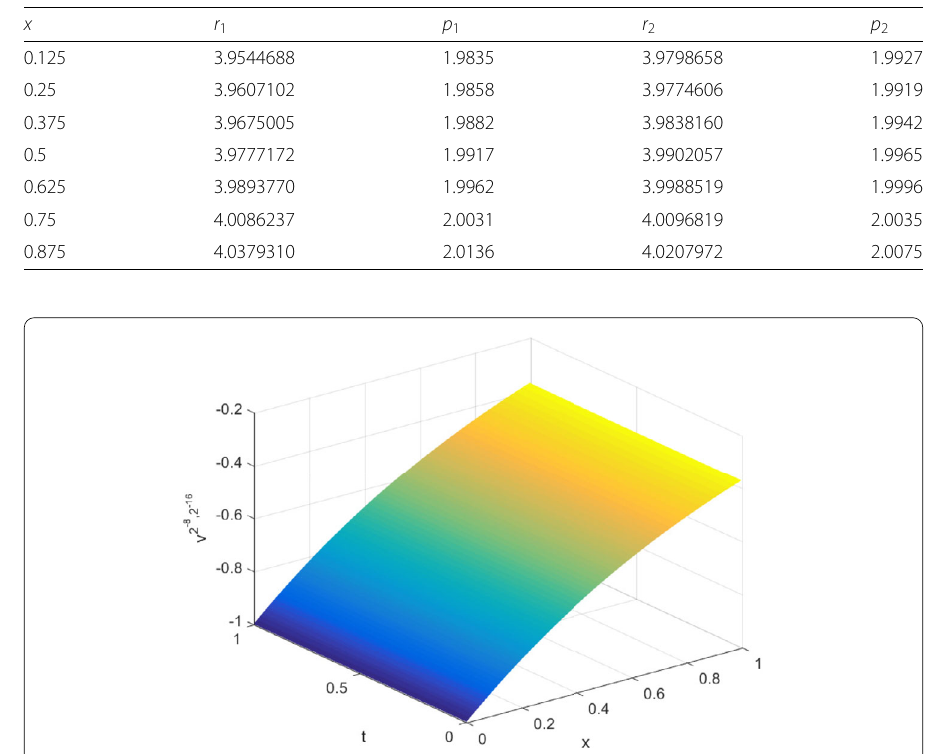
Figure 9 The grid function v 2–8,2–16 presenting the approximate solution (cid:11) v of ∂ x u when h = 2 –8 , τ = 2 –16 for Example